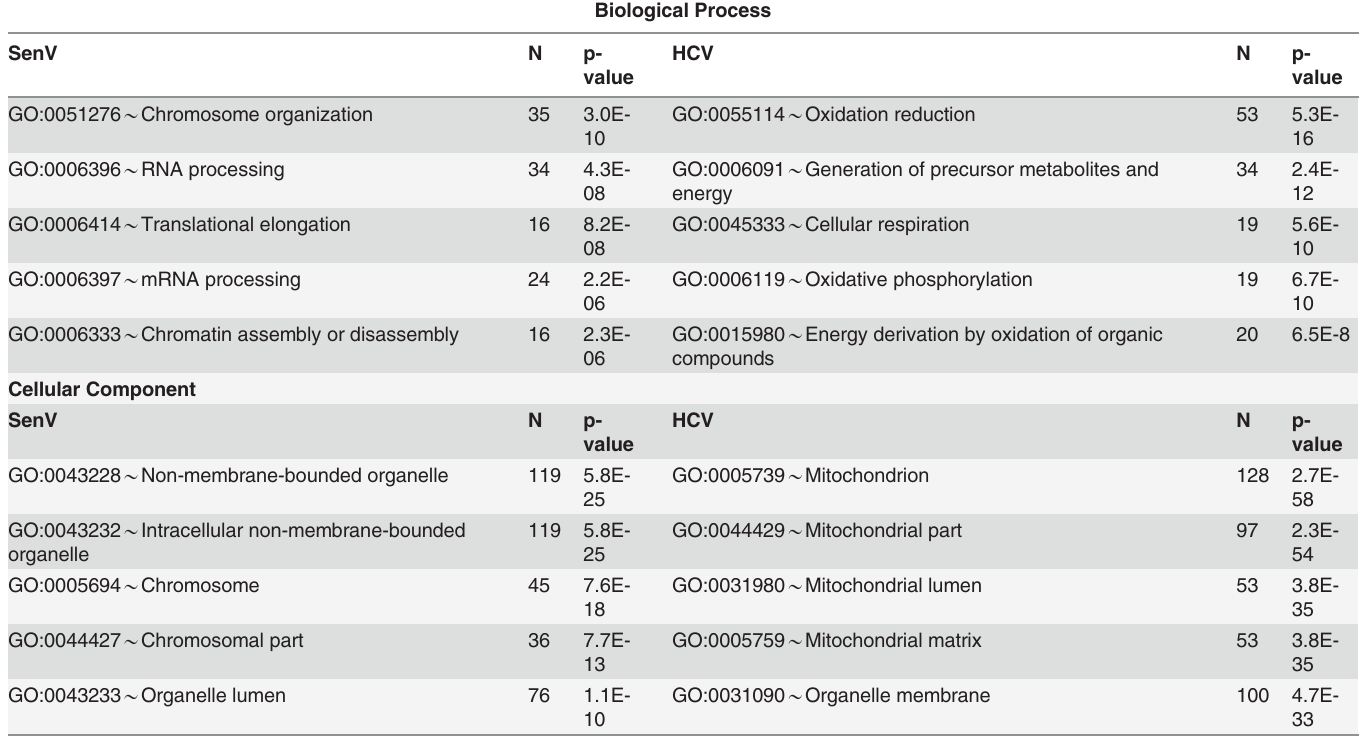
Table 2. Gene Ontology Analysis for proteins that leave the MAM during RNA